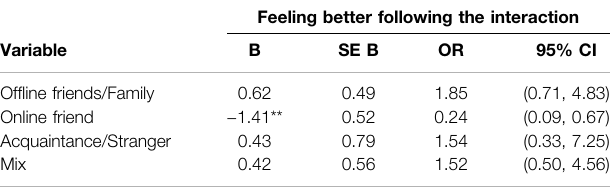
TABLE 3 | Generalized Estimating Equation (GEE) model predicting feeling better after interaction by relationship